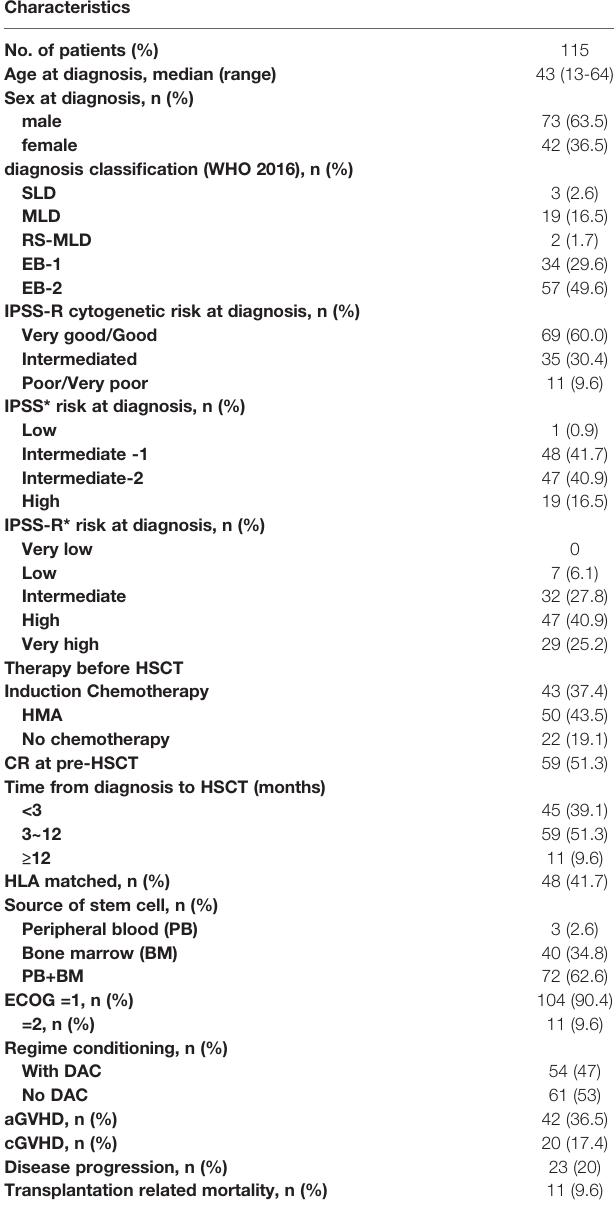
TABLE 1 | Clinical characteristics of